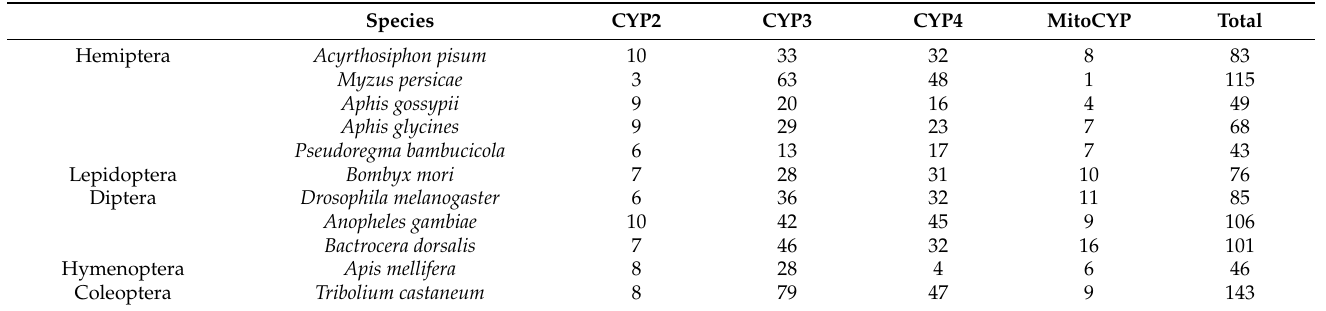
Table 2. Summary of P450s in Pseudoregma bambucicola and some other insect species.